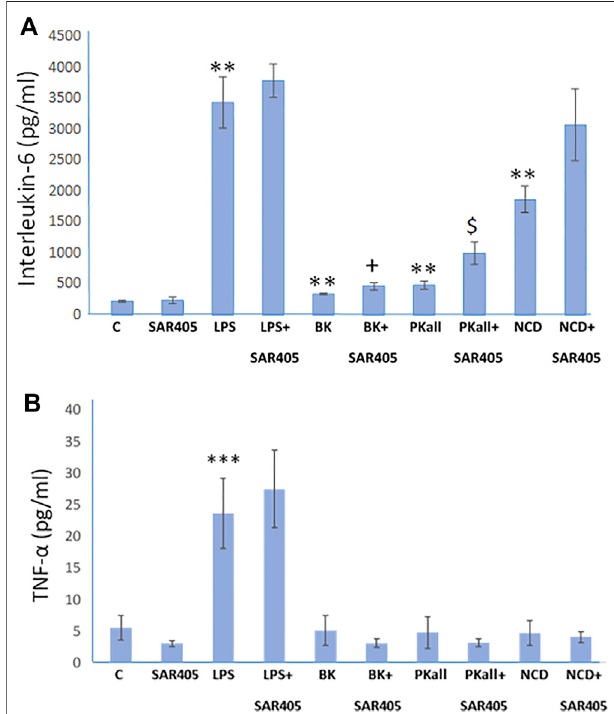
FIGURE 5 | Autophagy and microglial in fl ammatory signals. To determine if autophagy plays a role in the microglial in fl ammatory response, microglial cells were exposed to LPS (100 ng), BK (10 − 7 M), PKall (2.5 ng/ml), or NCD (16.5 µg protein/ml) for 24 h, in the presence and absence of SAR 405 (1 µM), a phosphatidylinositol 3-kinase, catalytic subunit type 3 (PIK3C3) inhibitor, that inhibits autophagy. The bar graph shows the levels of (A) interleukin-6 (IL-6, pg/ml) and (B) tumor necrosis factor-alpha (TNF- α , pg/ml) released into the media and measured by ELISA (** p ≤ 0.02 or less vs. C, *** p ≤ 0.004 vs. C; $ p ≤ 0.009, PKall vs. PKall + SAR405; + p ≤ 0.037, BK vs. BK + SAR405, n (cid:1)